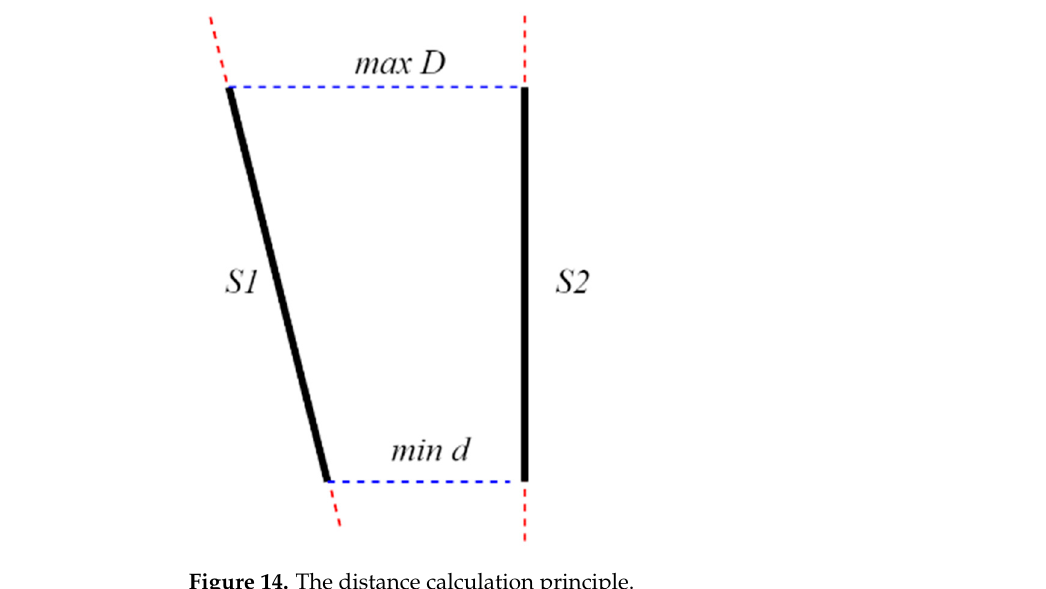
Figure 14. The distance calculation principle.